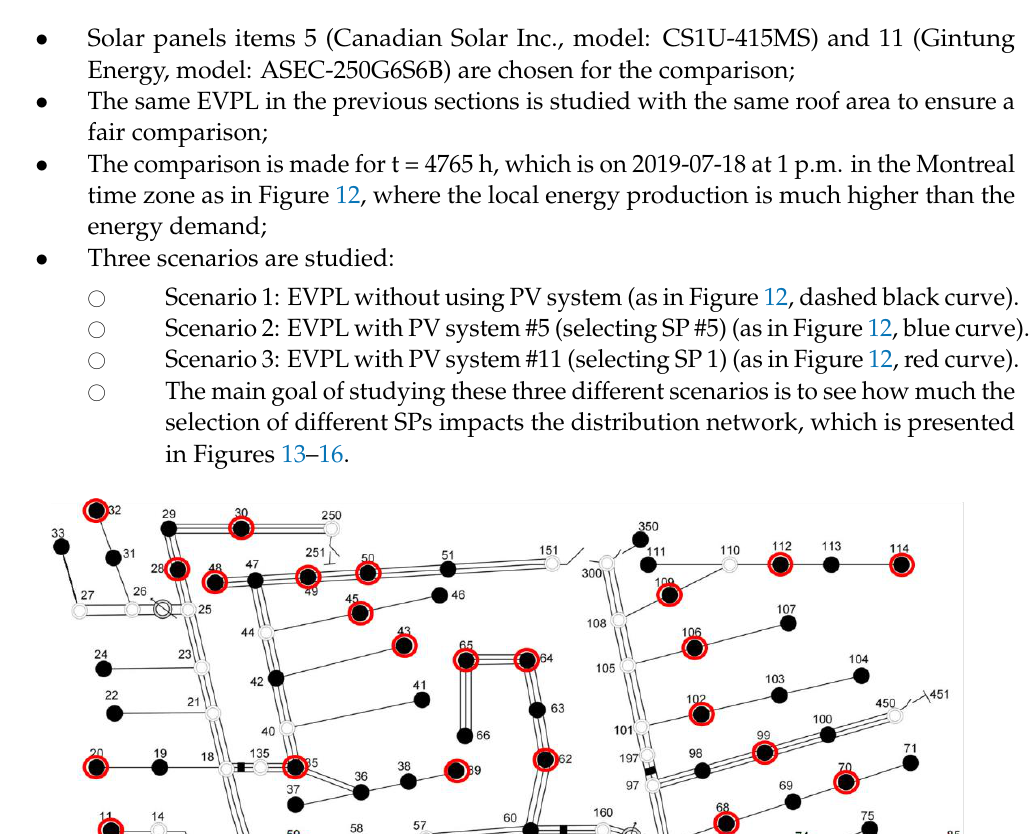
Table 8. Summary of the comparison between RWR to TOPSIS.